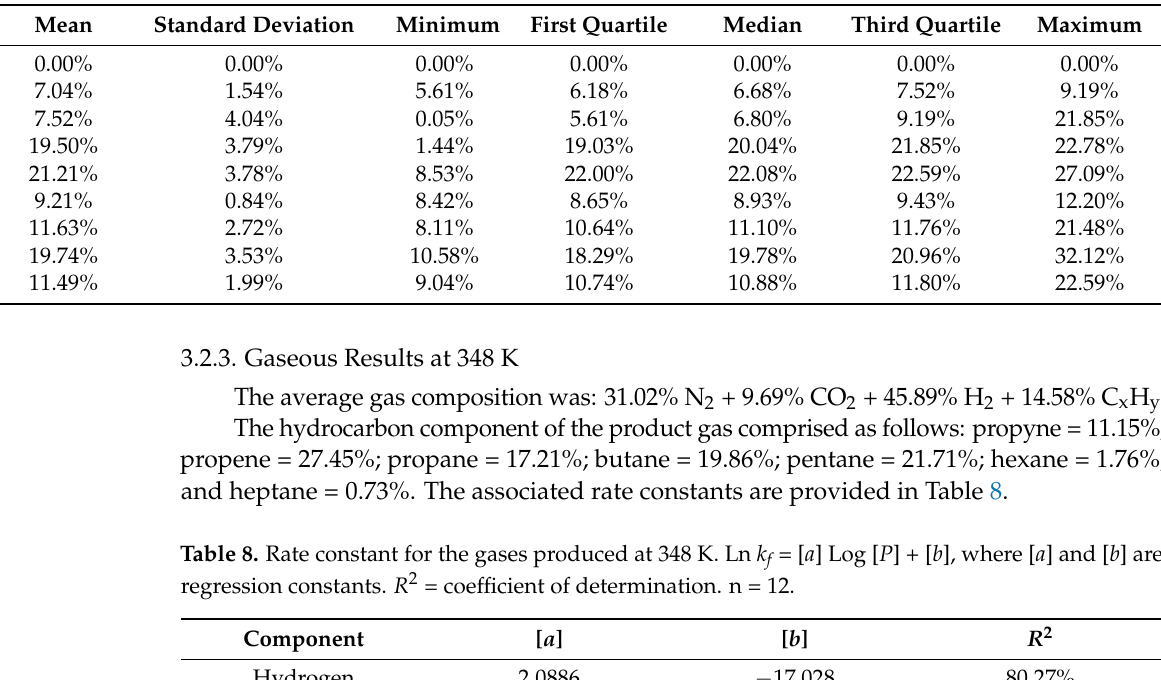
Table 7. Molar composition of the clear liquid hydrocarbon. n = 57.